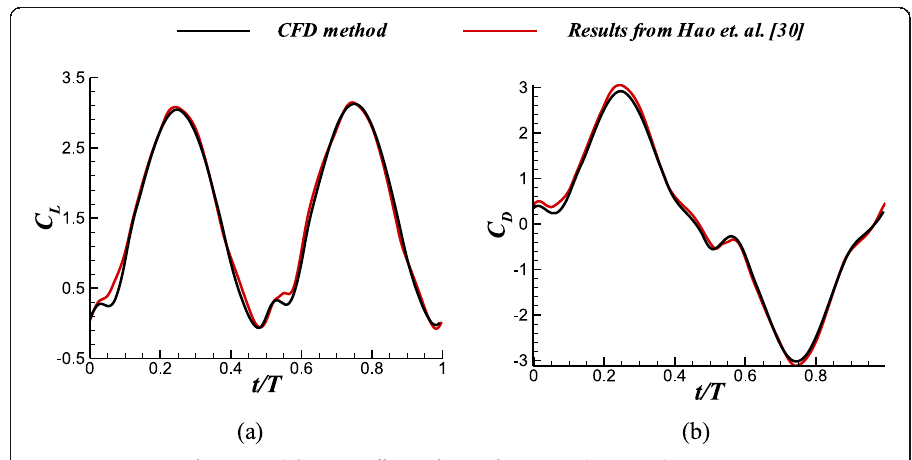
Fig. 5 Comparison of ( a ) C L and ( b ) C D coefficient from reference and ANSYS